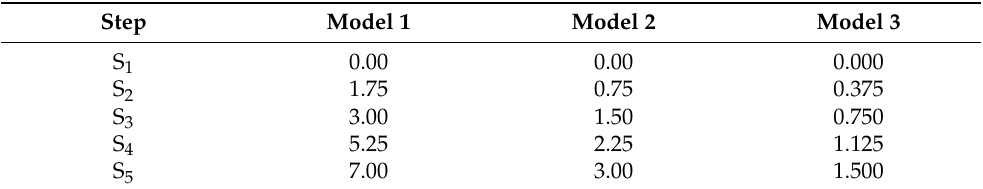
Table 5. Relevant stroke parameters of the flange (unit: mm).